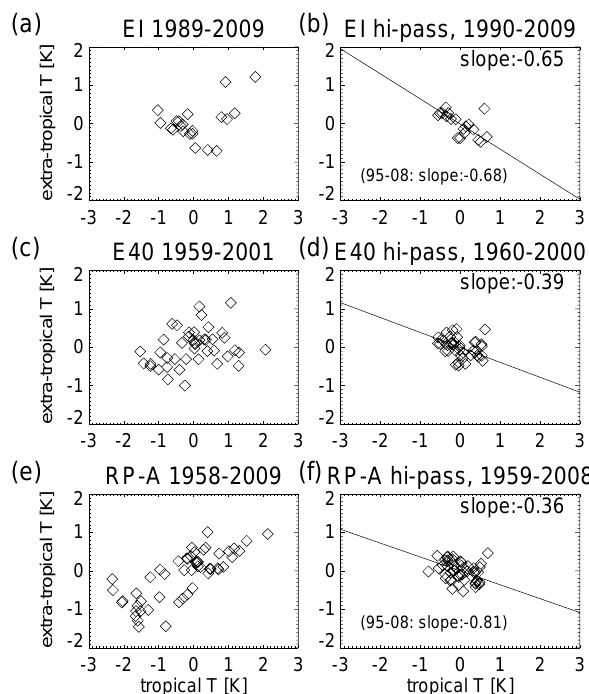
Fig. 9. Temperature correlations tropics-extratropics for annual means as reported (left column) and after high-pass filtering (right column, 3-year running mean subtracted from original timeseries). (a) ERA-Interim data at 67hPa, 1989–2009. (b) Ditto, hi-pass fil- tered. (c) ERA-40 data at 70hPa, 1959–2001. (d) Ditto, hi-pass filtered. (e) RATPAC-A data at 70hPa, 1958–2009. (f) Ditto, hi- pass filtered. Slopes in panels (b, d, f) refer to data periods as in- dicated in plot titles. For ERA-Interim and RATPAC-A the slopes have been calculated also for the common period 1995–2008 (see bracketed text in panels (b/f)